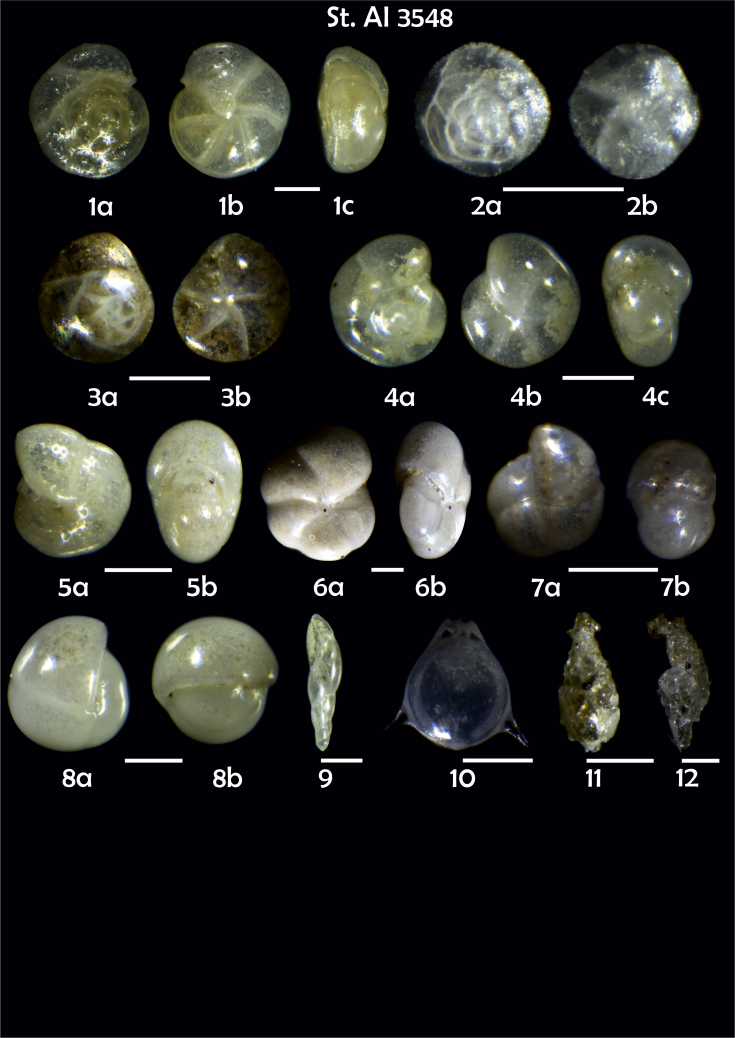
Station 35481Cibicidoides bradyi, a umbilical view, b spiral view, c apertural view. 2Alabaminella weddellensis,a spiral view, b umbilical view. 3Epistominella exigua,a spiral view, b umbilical view. 4 ?, like 3556 (1), a unbilical view, b spiral view, c apertural view. 5Melonis sp. cf. M. barleeanus, a side view, b apertural view. 6Pullenia sp., a side view, b apertutal view. 7P. bulloides, a side view, b apertural view. 8P. bulloides, a side view, b apertural view. 9Fursenkoina complanata.10Fissurina staphyllearia. 11Lagenammina difflugiformis.12Reophax fusiformis?. Scale 100 μm.